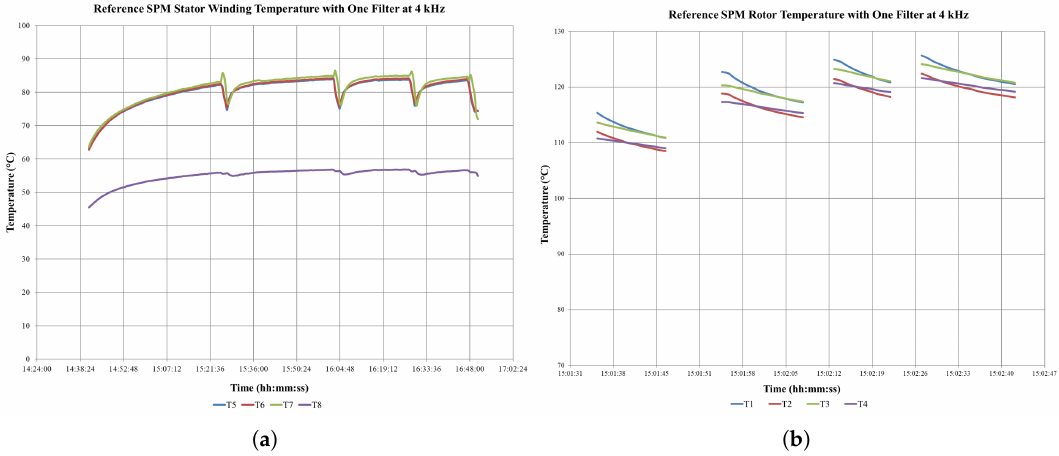
Figure 13. Temperature profiles during thermal equilibrium with one resistor–inductor (RL) filter at 4 kHz with three, two and one input filters: ( a ) thermocouples on stator winding; ( b ) thermocouples on permanent-magnets .